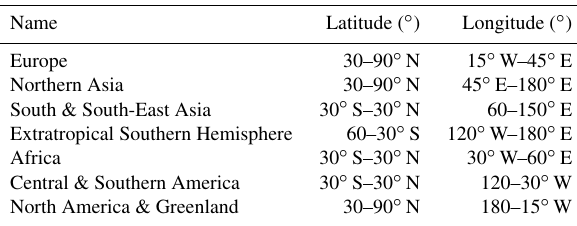
Table 2. List of regions used. Only land grid points are used in the